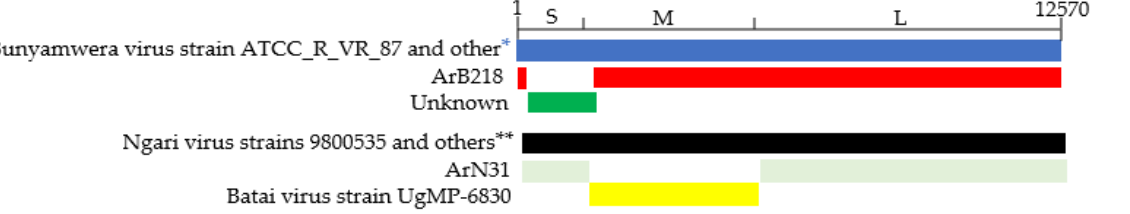
Figure 1. Representation of recombination events between our strains and the sampled sequences. *: Bunyamwera virus (reference strain). **: Ngari virus strains (15Guidimaka_ME, 428Trarza_ME, 9800521, D28542_4e, HKV66, HKV141, and Adrar).